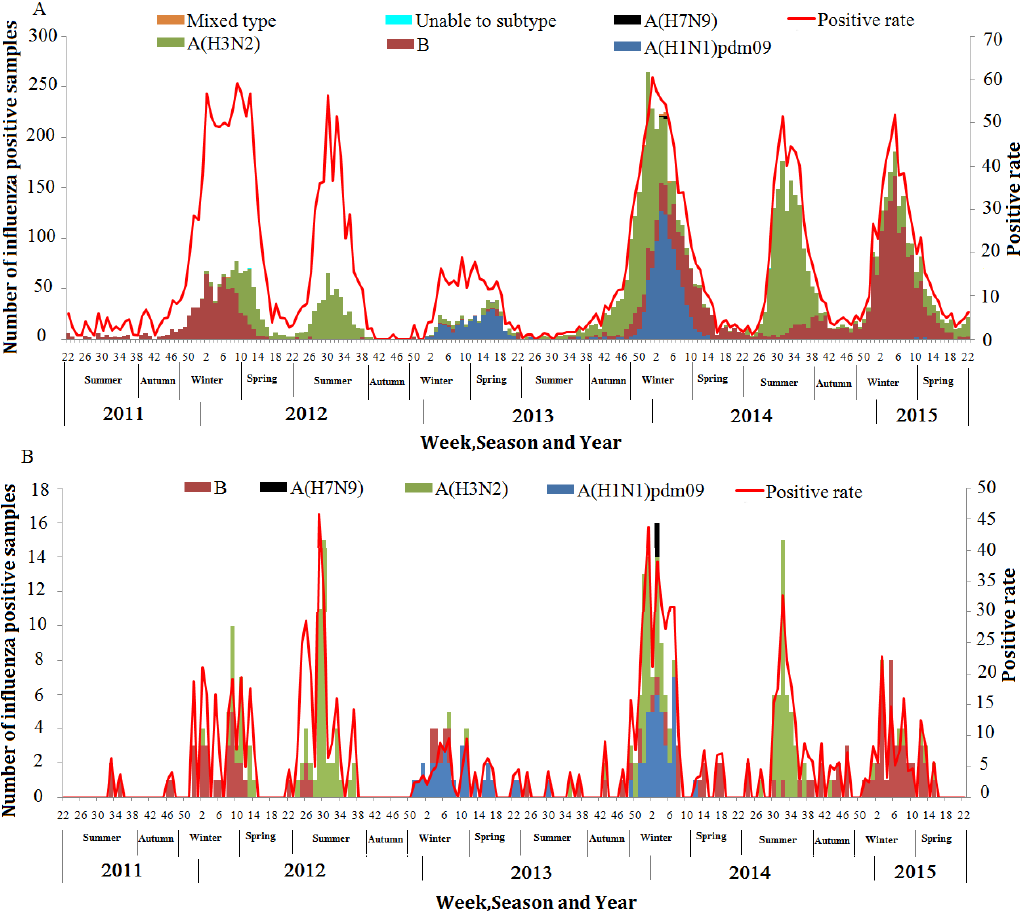
Figure 5. Temporal distribution of influenza virus-positive specimens and the percentage of specimens testing positive, in Zhejiang Province, March 2011–June 2015. ( A ) Influenza-like illness (ILI) influenza virus-positive patients (N = 8260); ( B ) Severe acute respiratory illness (SARI) influenza virus-positive patients (N = 341).